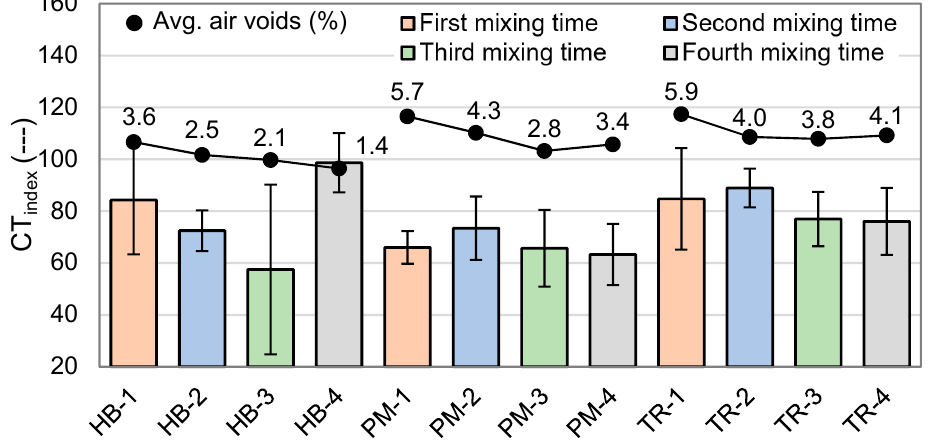
Figure 13. Crack tolerance index (CT index ) results at 25 °C ( n = 3).